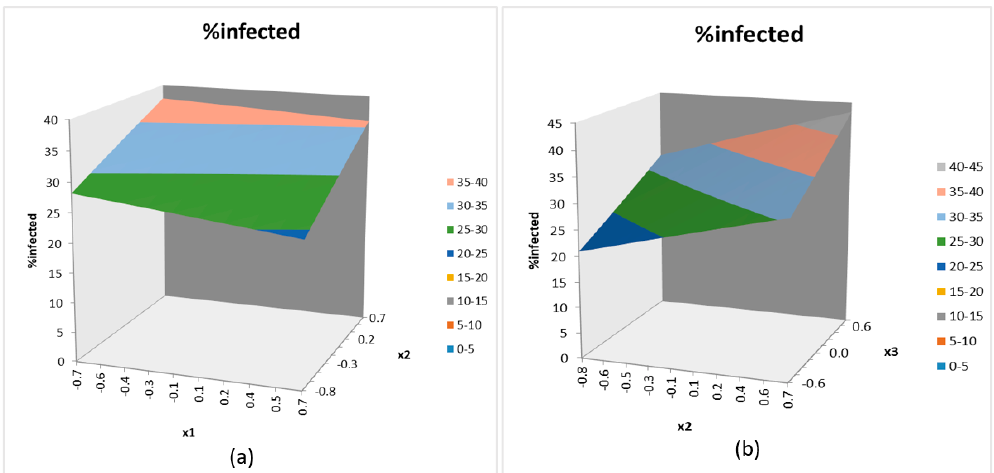
Figure 6. ( a ) Contour plot of persuasive-constant and environmental bias; ( b ) environmental bias and counseling of leader.